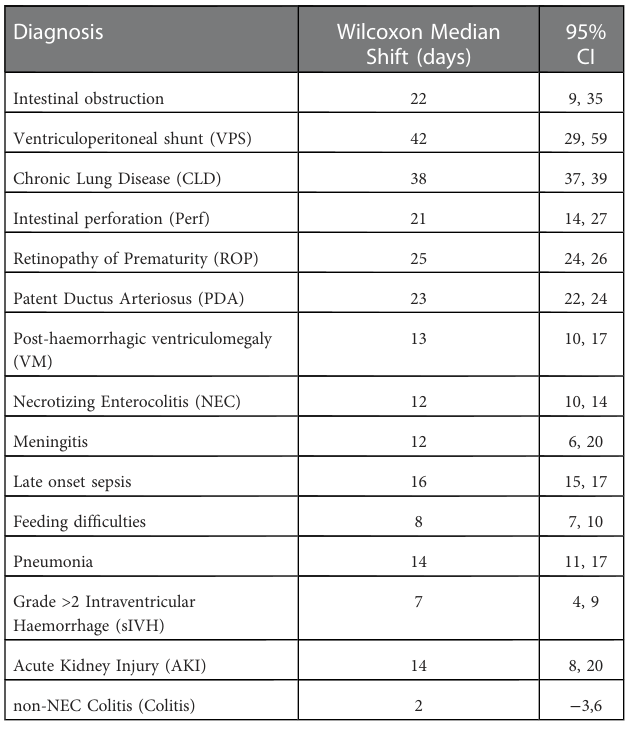
TABLE 3 Median shift of length of stay for each